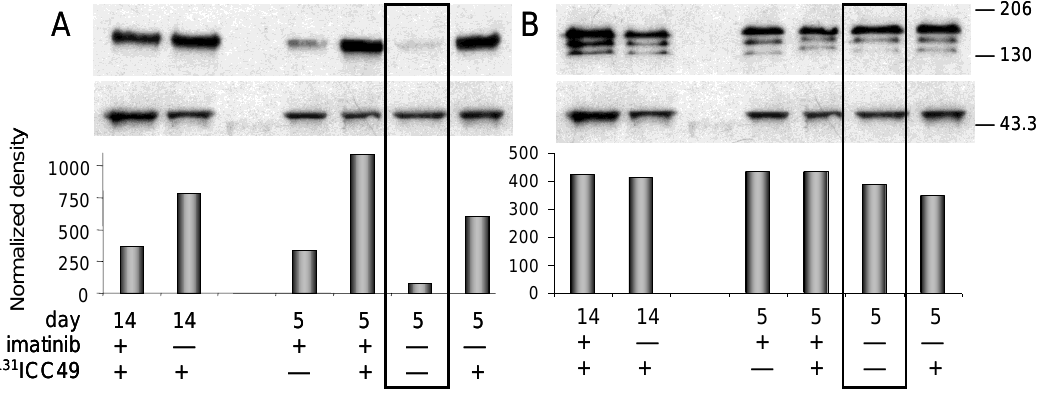
Figure 2. Expression of PDGFr-β in SW1990 human pancreatic SW1990 adenocarcinoma xenografts grown subcutaneously in athymic mice. (a) Phosphorylated PDGFr-β of human and mouse origin. Western immunoblotting analyses of phosphorylated PDGFr-β with rabbit anti-human/anti-mouse phospho-PDGFr-β (Tyr751) polyclonal Ab3161 antibodies. The lower panel is the same membrane probed with rabbit anti-β-actin mAb 13E5. The bar graph represents protein band intensity normalized to the protein load as measured by the intensity of β-actin band using ImageJ. (b) Total PDGFr-β. Western immunoblotting analyses with rabbit anti-human/anti-mouse PDGFr-β polyclonal Ab3162 to determine the total expression of PDGFr-β in response to various treatments. The lower panel is the same membrane probed with rabbit anti-β-actin mAb 13E5 to determine total protein load per lane. The bar graph represents protein band intensity normalized using ImageJ to the protein load as measured by the intensity of β-actin band. Immunoblots for β-actin are identical in A and B because the same membrane was re-probed. Data for xenografts from control mice sham-treated with PBS are framed by the black rectangle.